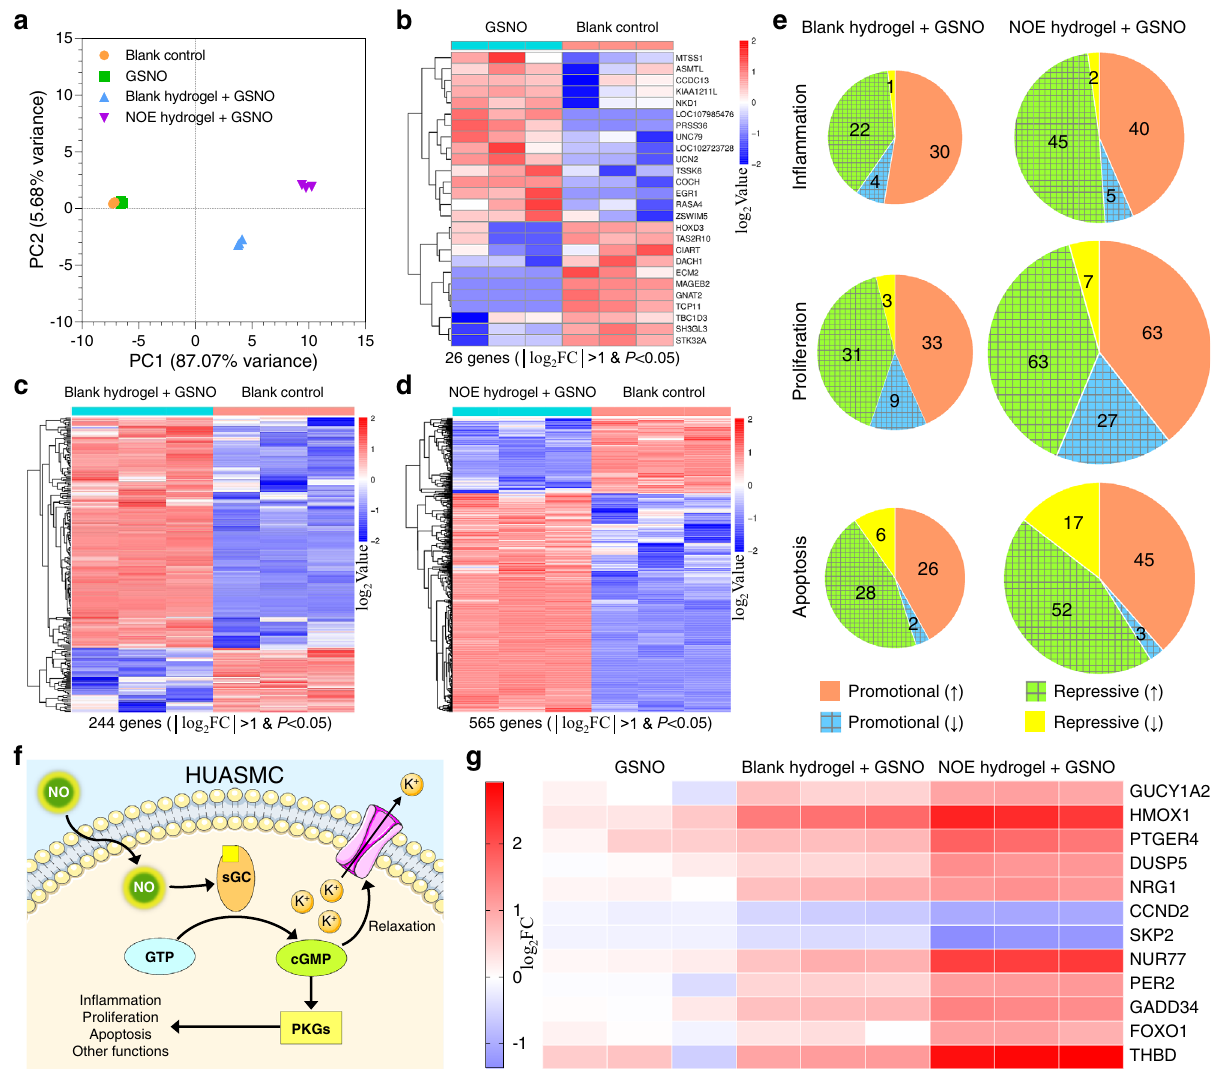
Fig. 5 Transcriptome analysis of human umbilical artery smooth muscle cells (HUASMCs). a Principal component analysis (PCA) representing the general variations in gene expression of HUASMCs among different groups. The nitric oxide-eluting (NOE) hydrogel containing 1.0 mM selenocystamine (SeCA) was selected as the delegate. b – d Differential gene expression heat maps of HUASMCs after various treatments when compared with the blank- control group. The gene expression levels for each set of comparison were normalized to the mean values within those two groups. Two-tailed Student ’ s t -test was assumed to determine the difference between two groups. e Pie charts displaying the changes and numbers of signi fi cantly differential gene expression related to in fl ammation, proliferation, or apoptosis. The area of a pie represents the number of genes involved in. The gridded region represents the total number of anti-in fl ammatory, anti-proliferative, or antiapoptotic alterations in gene expression. f Schematic illustration of NO signaling pathway. g Heat map showing the relative changes in expression level for selected genes when compared with the blank-control